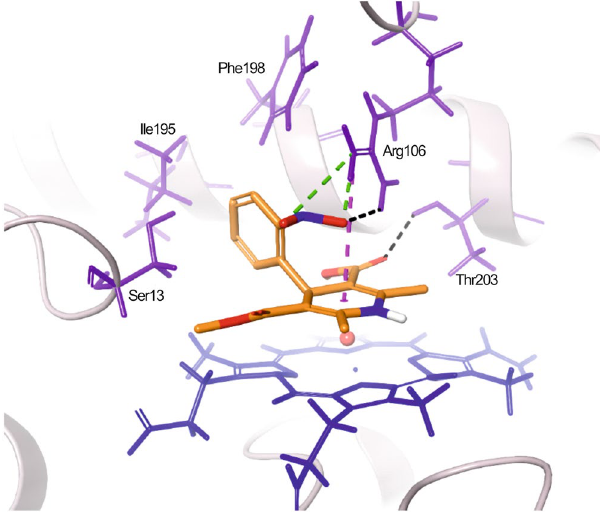
Figure 4. NIF-amino acid interactions in the CYP3A48 substrate pocket. Residues that line the substrate- binding pocket are highlighted by purple , the heme group is shown by blue and the CYP backbone by grey ribbon. Black dashes indicate hydrogen bonding, green dashes salt bridges and magenta dashes π -cation